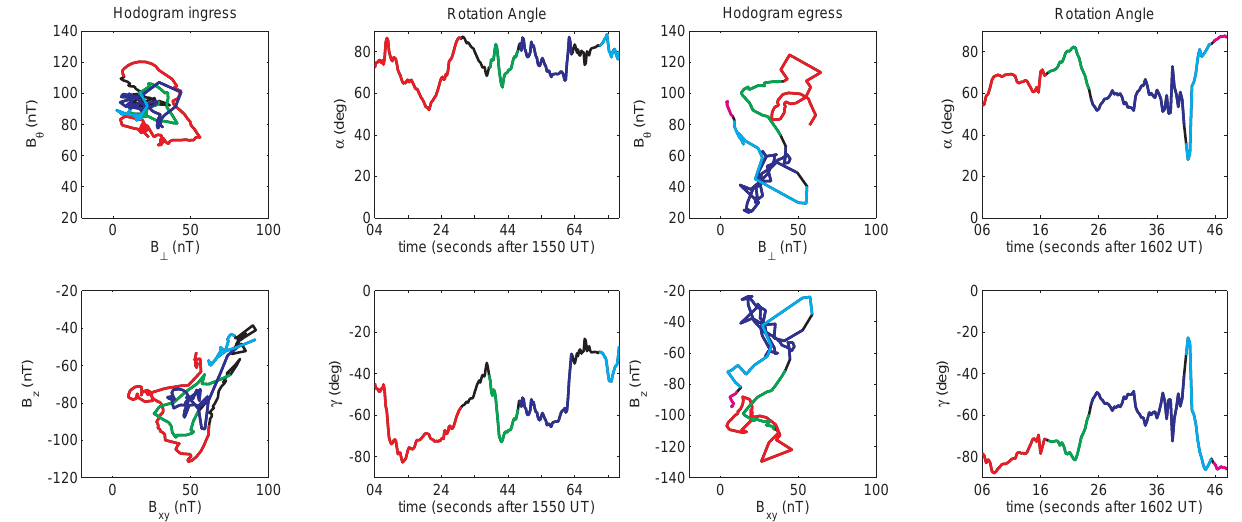
Fig. 6. Left: G8 inbound magnetopause crossing hodogram for the interval 15:50:04–15:51:24UT. Right: the same for the G8 outbound magnetopause crossing for the interval